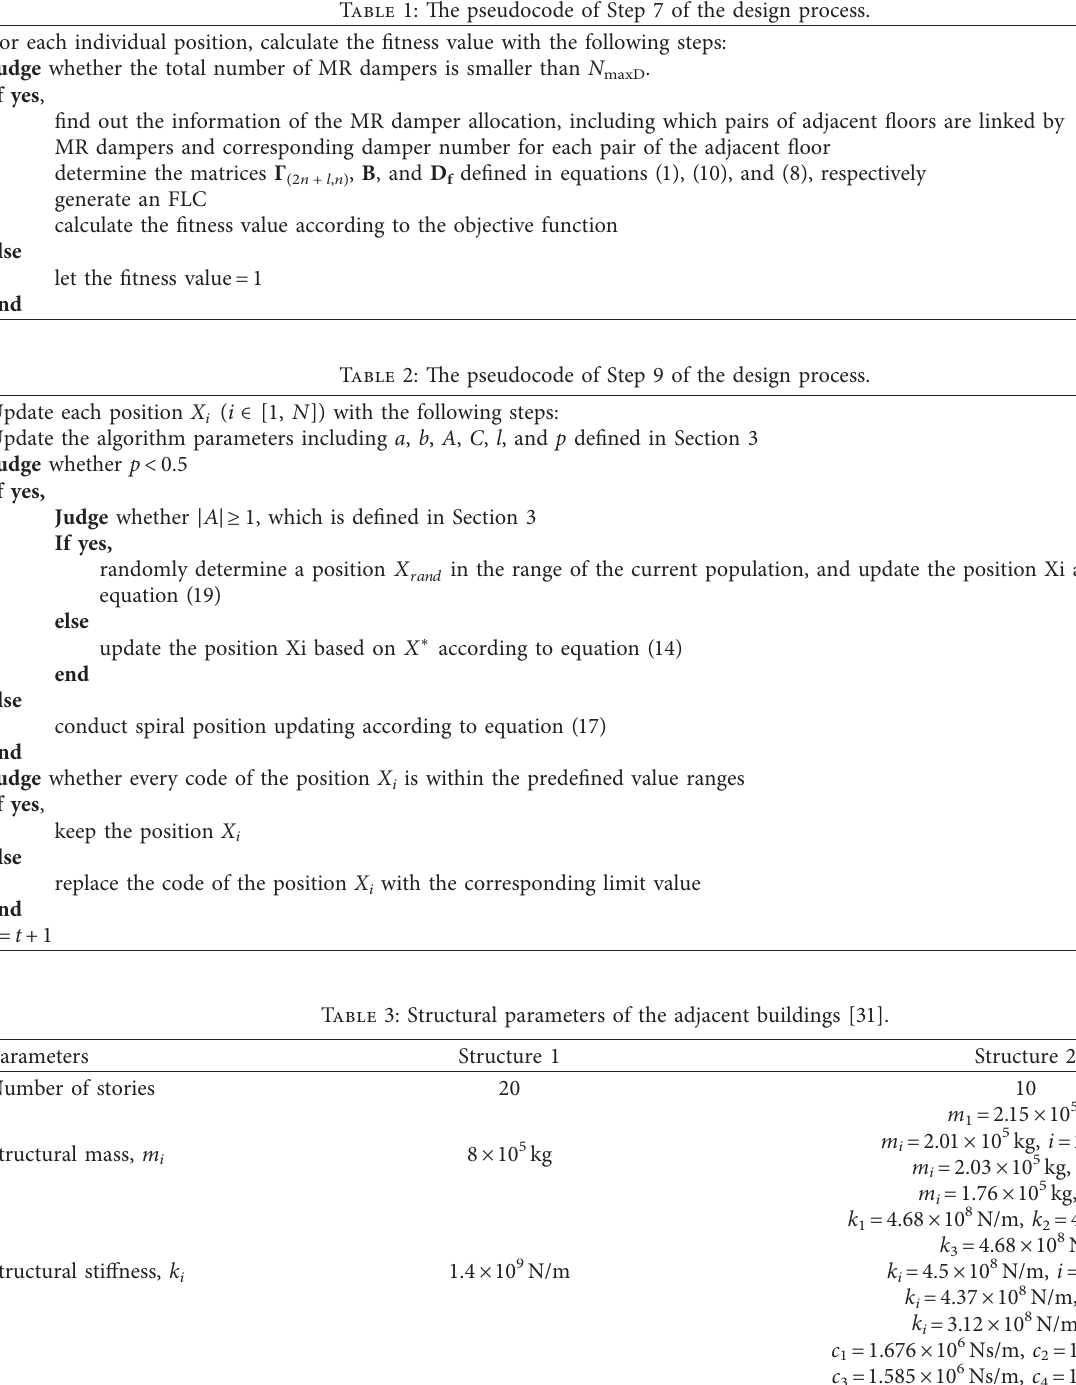
Table 1: The pseudocode of Step 7 of the design process.